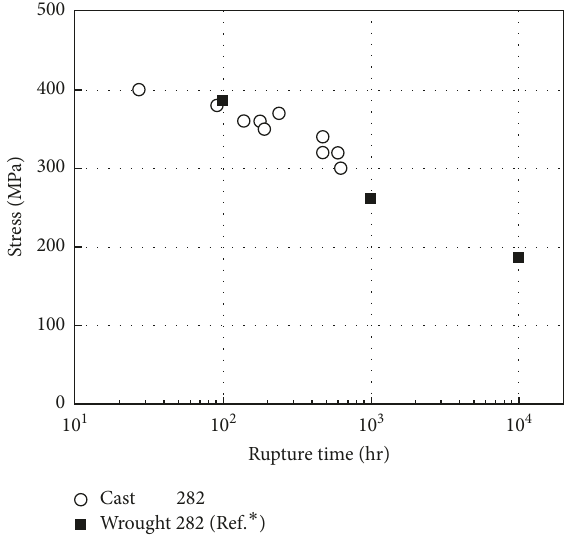
Figure 10: Creep rupture life versus stress of Haynes 282 wrought and cast